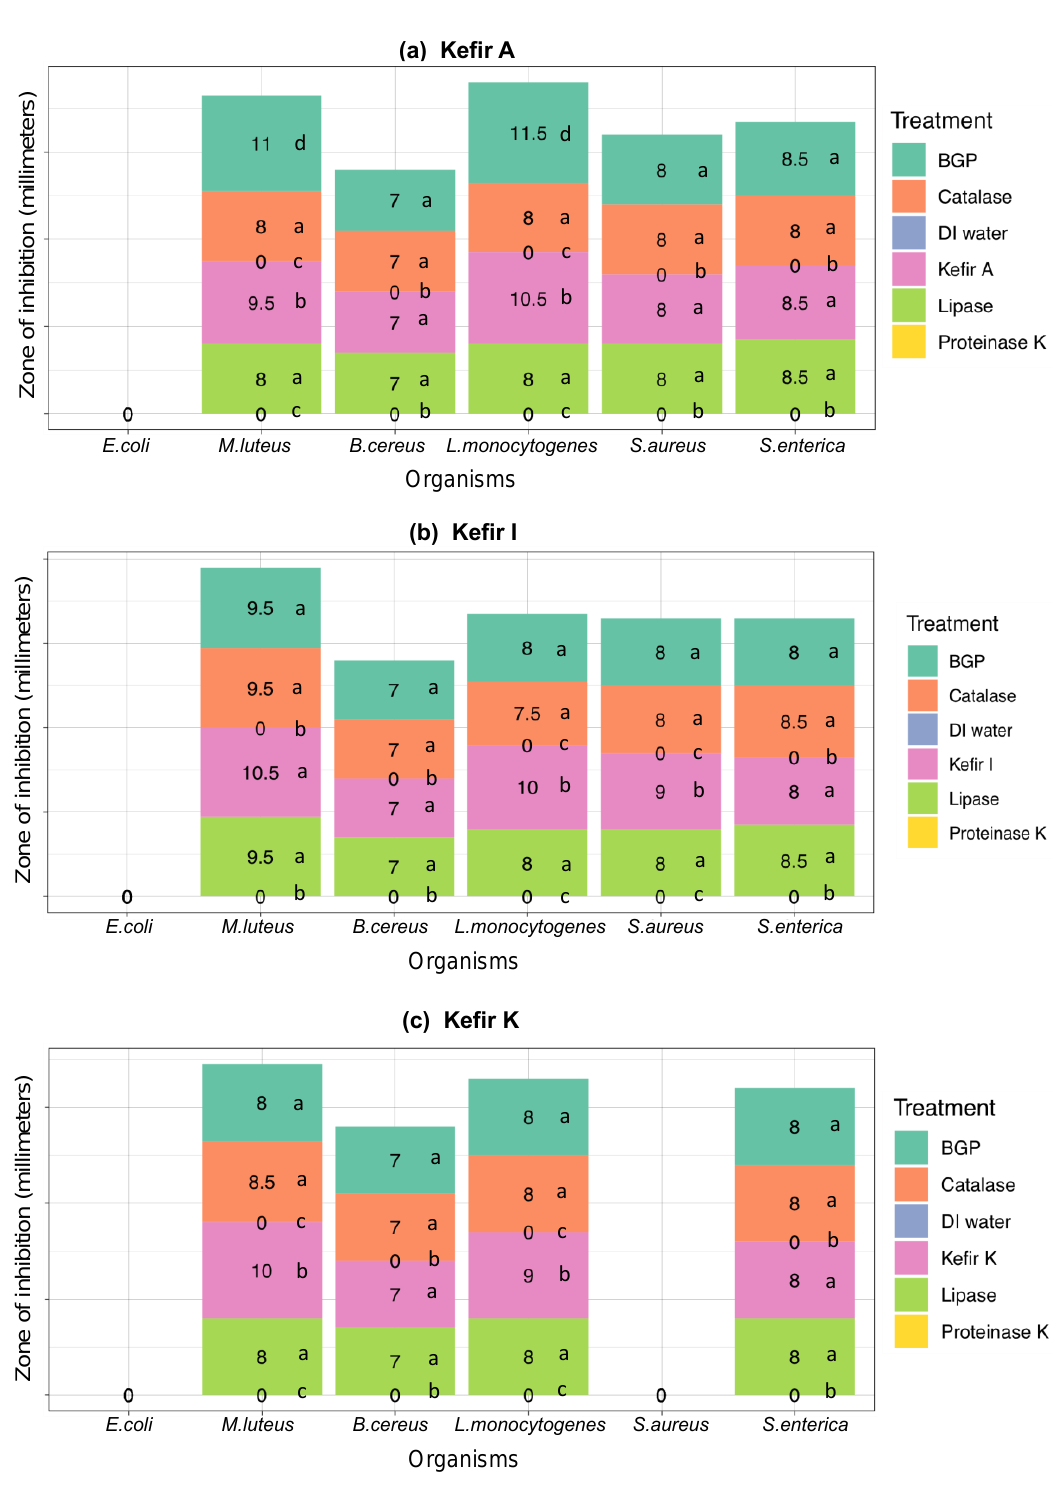
Figure 2. Bacteriocin-based antimicrobial activity in filter-sterilized artisanal kefir samples